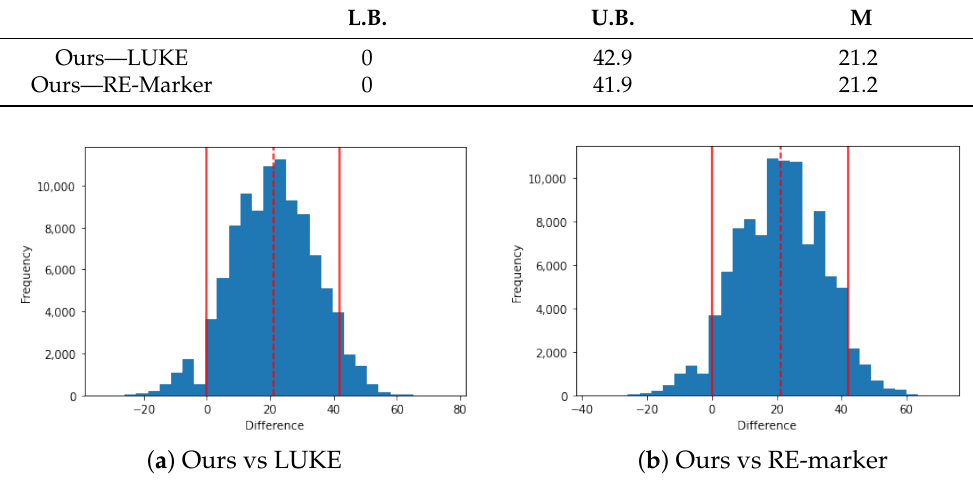
Figure 3. Distribution of the bootstrapping results. We calculated the difference between MC F1 scores of ours and LUKE ( a ) and RE-marker ( b ), respectively. X -axis represents the difference between MC F1 scores and Y -axis represents the frequency. The value of lower bound and upper bound (solid line), and median (dotted line) under 90% confidence level is marked in the figures.